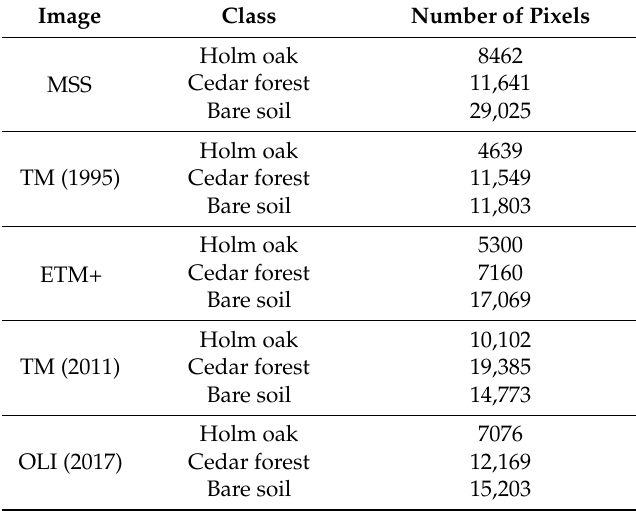
Table 2. The number of pixels used for